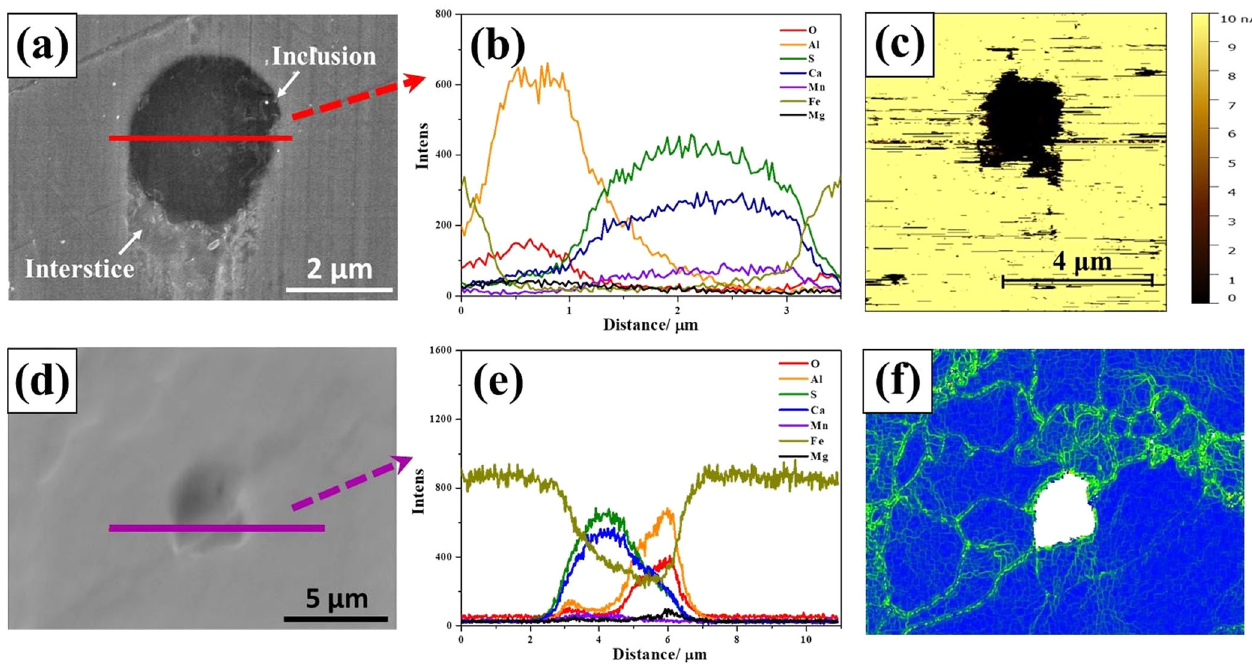
Fig. 11 Morphology and properties of (Al, Mg, Ca, Mn)-oxy-sul fi de inclusions in weathering steel. a , d SEM images of target (Al, Mg, Ca, Mn)-oxy-sul fi de inclusions and its corresponding element distribution results. c Conductive map of the target inclusion in the same region shown in a , obtained with a potential of + 5.0 V applied to the tip. f The KAM map of the same region shown in d 90